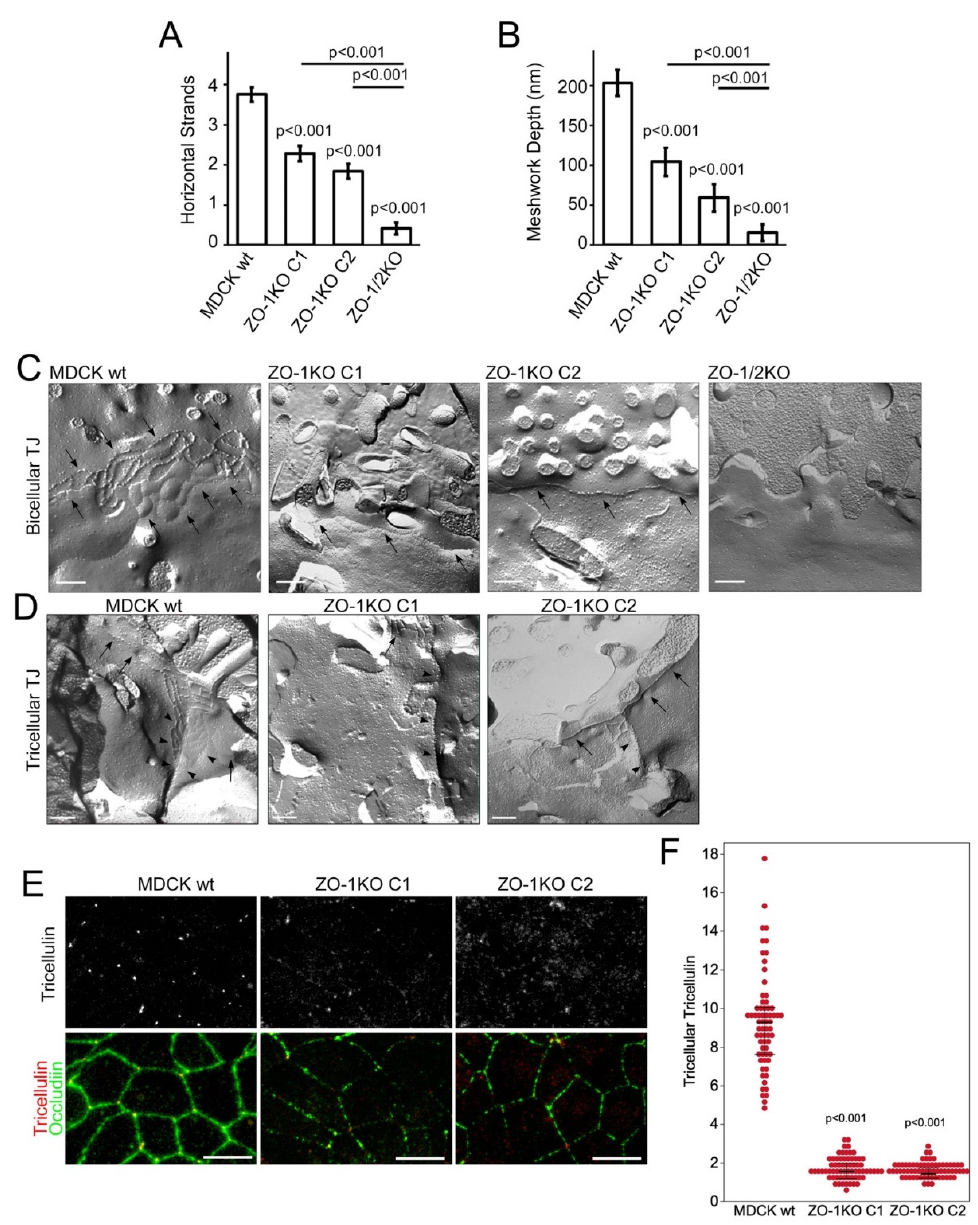
Figure 11. ZO-1-deficiency disrupts TJ ultrastructure. Freeze fracture analysis of TJ ultrastructure of confluent control (wt) and knockout MDCK cells. ( A ) Numbers of horizontal strands were reduced in ZO-1 KO cells as well as in the ZO-1/2 double KO clone. The double KO cells exhibited even more strongly reduced numbers of strands compared to the ZO-1 KO cells. Note, often no or only one TJ strand could be observed in various replicas of the double KO. ( B ) The meshwork extension was drastically reduced in ZO-1 KO cells as well as in the ZO-1/2 KO cells. Note, for occurrence of one strand no extension existed. The quantifications are based on the analysis of MDCK wt, 53; ZO-1KO C1, 28; ZO-1KO C2, 25; and ZO-1/2KO, 29 TJ. ( C ) Representative images of bicellular TJ in MDCK wt and the respective ZO-1 and ZO-1/2 KO cells. Arrows indicate intramembrane strands. ( D ) Images of tricellular TJ of MDCK wt and the ZO-1 KO cells suggested that in the ZO-1 KO only the central tube was present and the typical horizontal branches as seen in the wild-type controls cells were missing. Arrowheads point to intramembrane strands that are part of tricellular junctions and arrows to strands in bicellular junctions. ( E , F ) Confocal maximum intensity projections of junctional xy-sections taken from cells stained for tricellulin and occludin. Panel ( F ) shows quantifications of accumulation of tricellulin in tricellular corners. Magnification bars, ( C , D ) 200 nm; ( E ) 20 μ m.